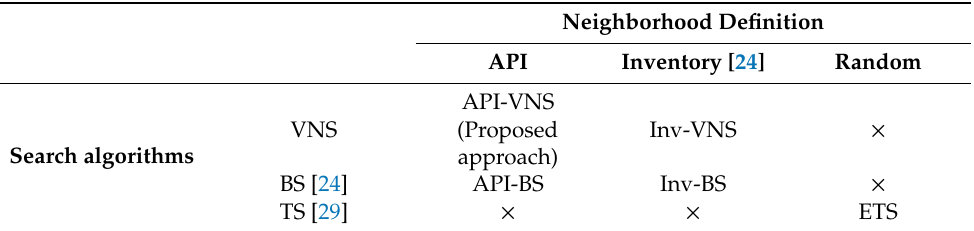
Table 1. Five methods for comparison in the numerical example. Neighborhood Definition API Inventory [24] Random API-VNS VNS (Proposed Inv-VNS Search algorithms approach) API-BS